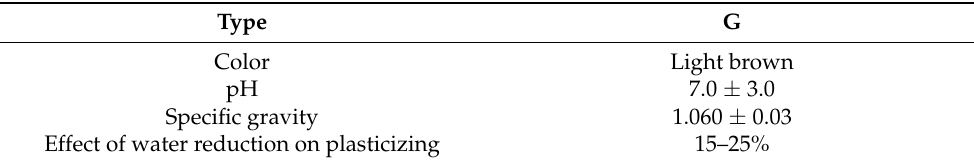
Table 4. Properties of the superplasticizer.